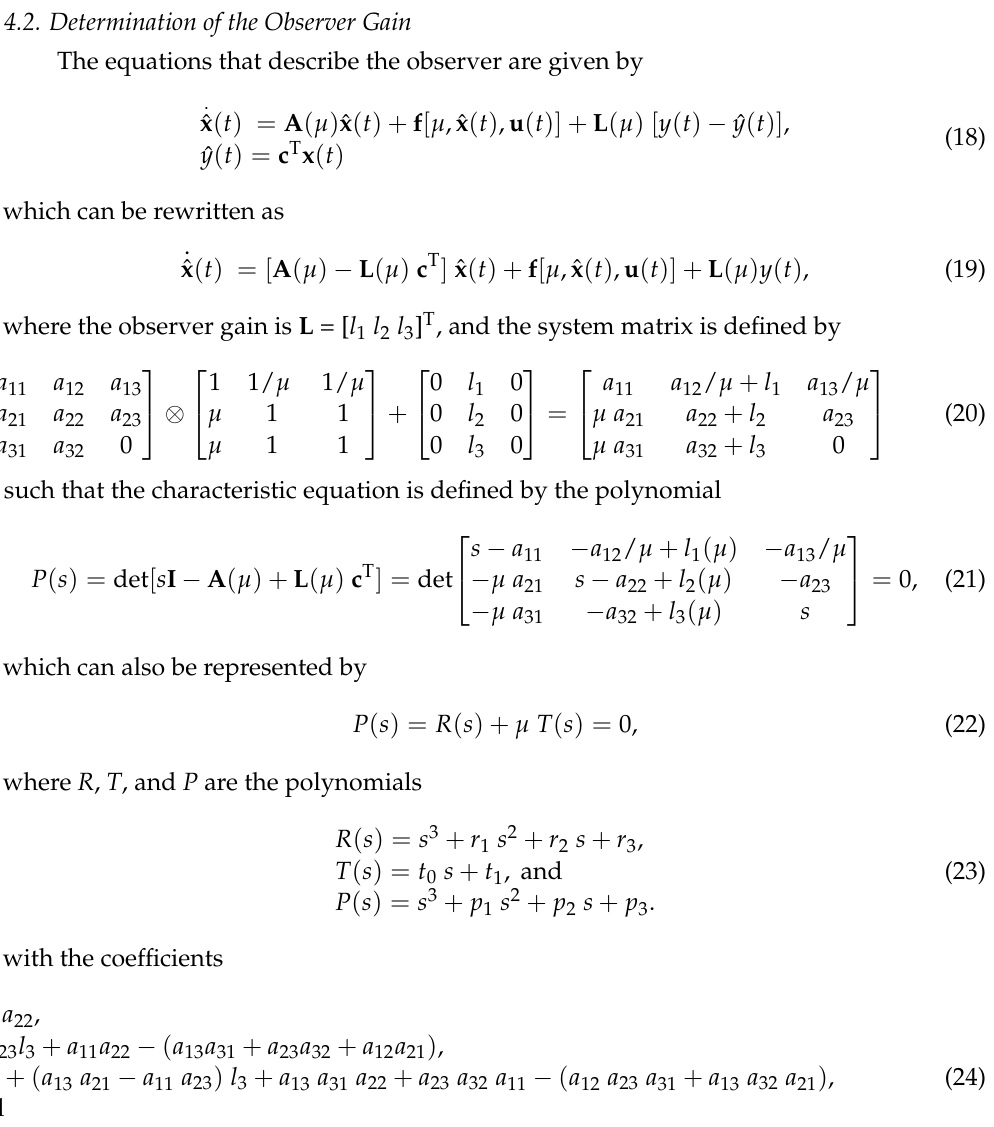
Figure 3. Block diagram for the observer given in Figure 2.